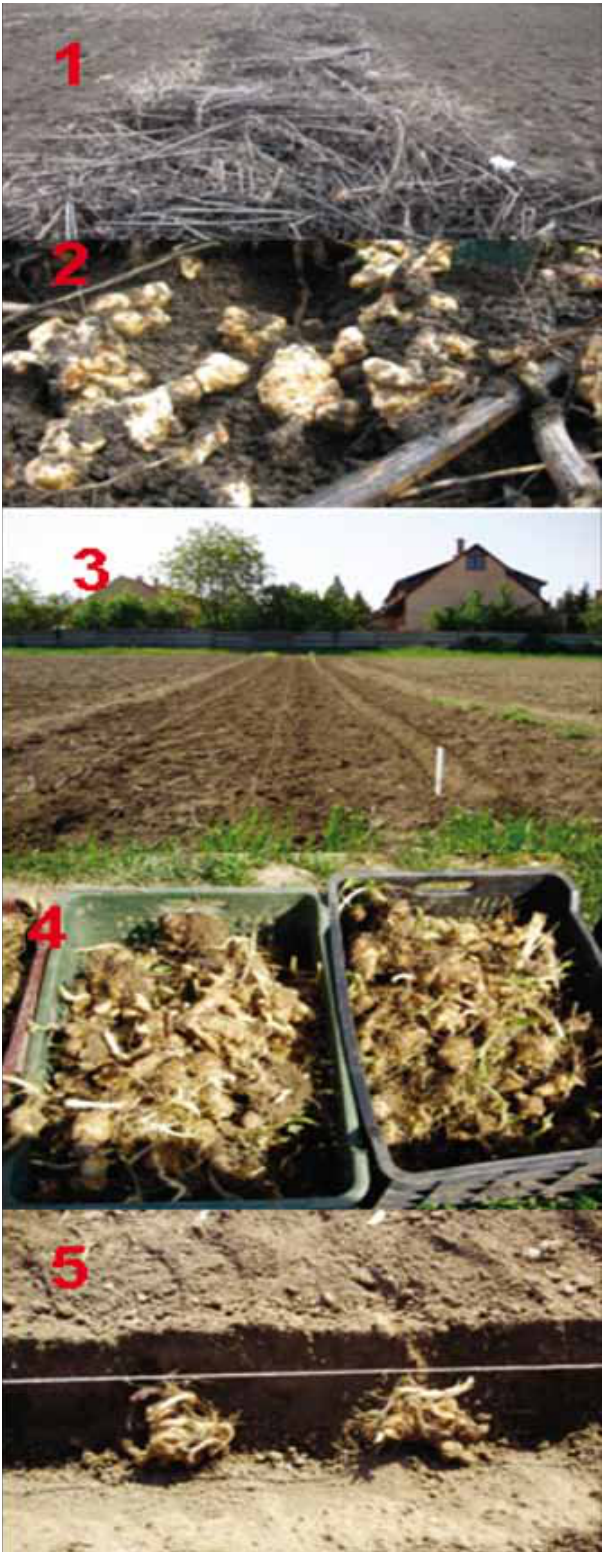
Fig. 1 : In vivo propagation of Jerusalem artichoke using tubers: Storing of tubers in the soil during winter season (photos 1 and 2); preparing soil for cultivation (photo 3); sprouted tubers, which cultivated in the field in April (photos 4 and 5) (Photos by N. Abd Alla, Demonstration Garden, Agricultural Botanics, Plant Physiology and Biotechnology Dept., Debrecen Uni., Hungary,